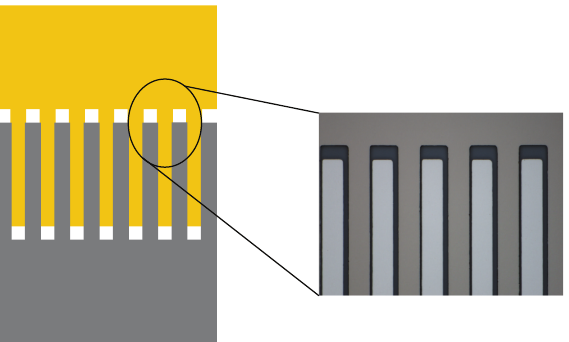
Figure 2: Interdigitated bimetal